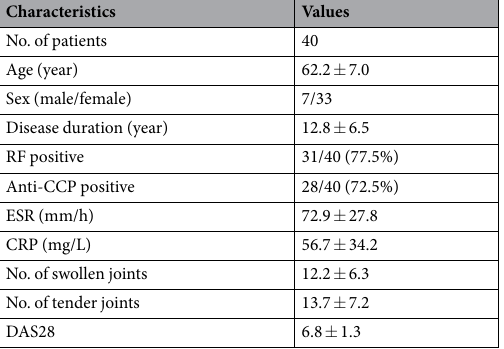
Table 1. Demographic and clinical characteristics of rheumatoid arthritis patients Note: RF, rheumatoid factor; anti-CCP, anti-cyclic citrullinated peptide antibody; ESR, erythrocyte sedimentation rate; CRP, C-reactive protein; DAS28, Disease Activity Score in 28